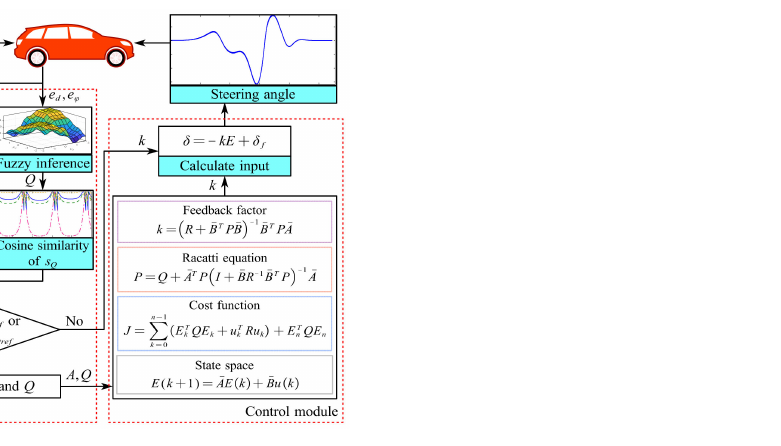
Figure 11. The structure of lateral path tracking-based LQR with fuzzy control and cosine similarity.